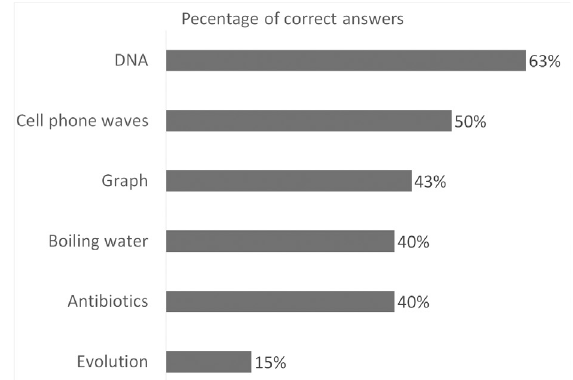
Figure 5. Correct responses about basic notions of science. 8 Basic notions about science related to Figure 5: a) DNA: Plant cells do not contain DNA; only animal cells contain DNA. From what you know, this is (true /